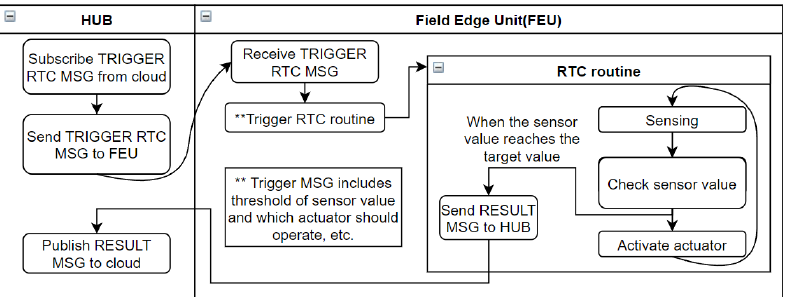
Figure 9. Schematic diagram of closed-loop control when the system determines its actuator’s action at the edge level.